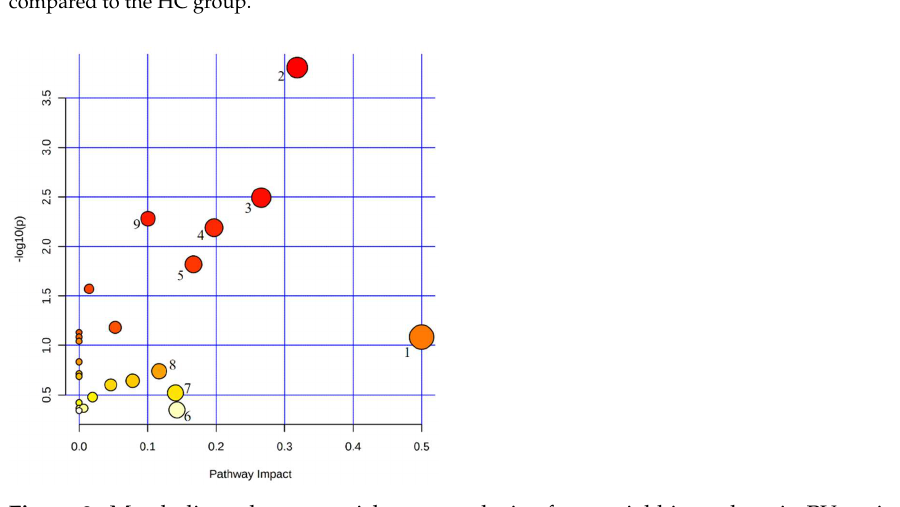
Figure 2. Metabolic pathways enrichment analysis of potential biomarkers in PV patients. 1. D-glu- tamine and D-glutamate metabolism. 2. Sphingolipid metabolism. 3. Pyruvate metabolism. 4. Ala- nine, aspartate and glutamate metabolism. 5. Arginine and proline metabolism. 6. Tryptophan me- tabolism. 7. Lysine degradation. 8. Arginine biosynthesis. 9. Glycolysis/gluconeogenesis.